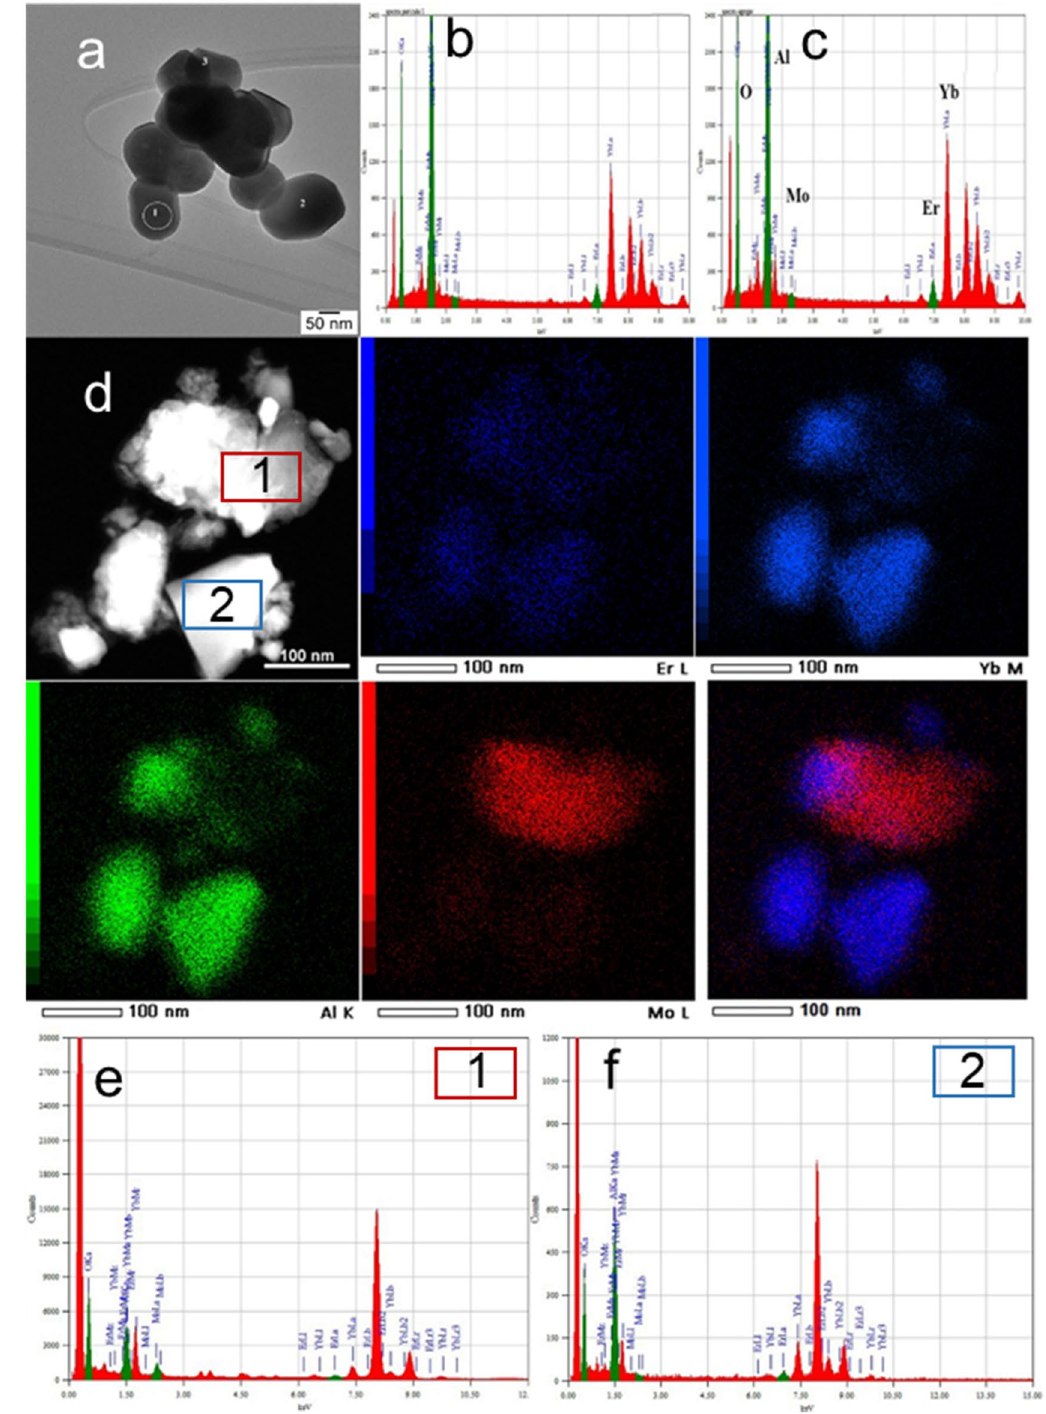
Figure 9. ( a ) Low magnification TEM image of an aggregate of Mo, Er-YbAG crystallites ( b,c ) EDX spectra measured on the crystallites indicated by (1) and (2) on the aggregate in ( a ); ( d ) HAADF-STEM image and the corresponding elemental mapping of Mo, Yb, Al and Er elements on a Mo, Er-YbAG aggregate; ( e,f ) EDX spectra acquired from the areas delimited by the rectangles 1 and 2 showing Mo depleted (1) and Mo enriched particles (2) the latter being enclosed by the Mo free YbAG particles. The Er doping level was subjected to gross errors due to overlapping between the M-lines of Yb, Er elements and L-line of Al range. We note that the investigation was pursued on tens of grains and spanned several months. According to TEM images (Fig. 9), the crystallites of (Mo)Er-YbAG are agglomerated, with dimensions between 50 and 200 nm, and monocrystalline with some facets.